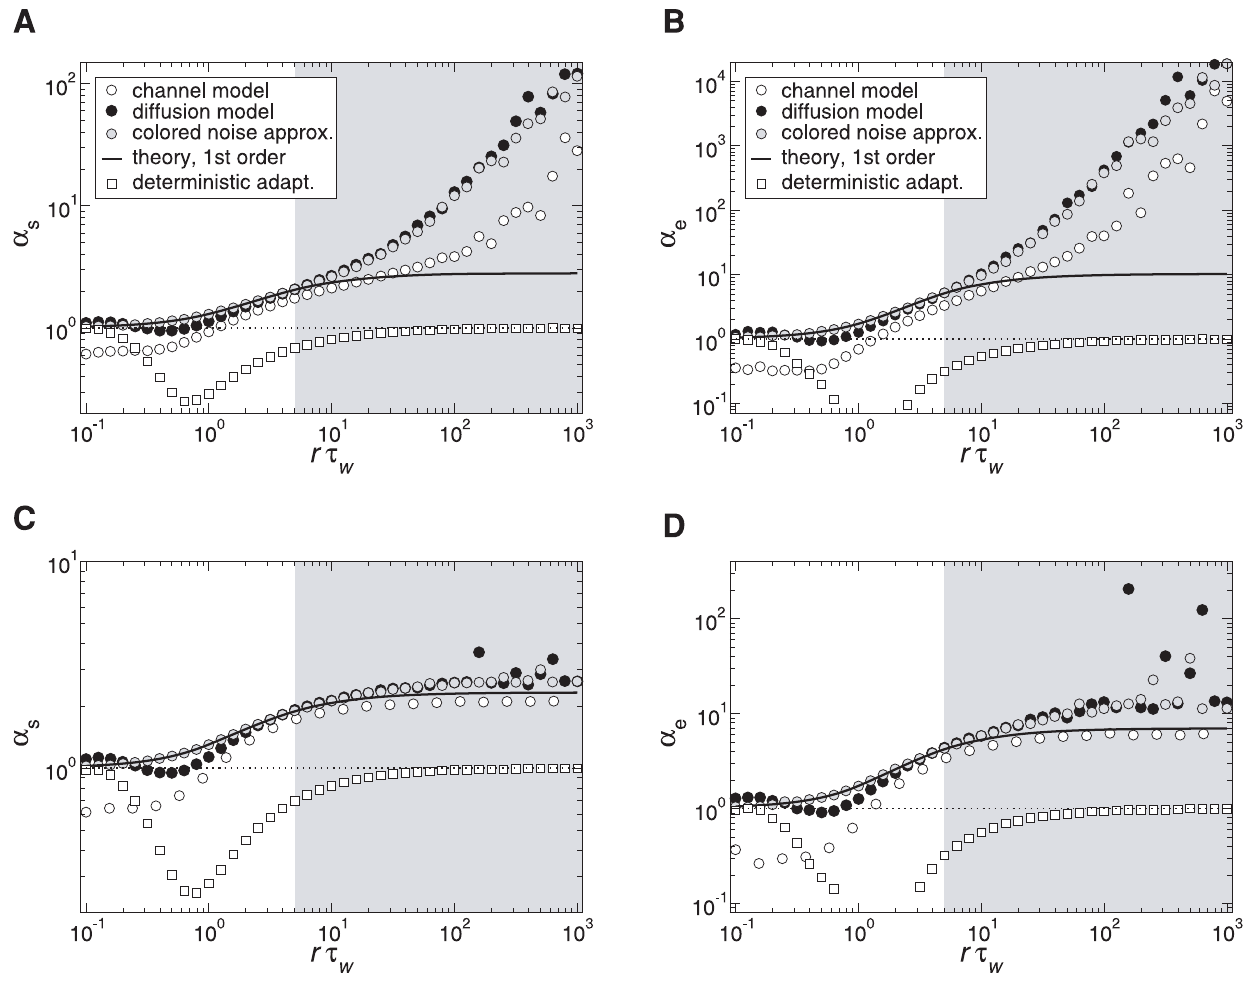
Figure 7. Shape parameters of the ISIH as a function of the time scale separation. A Rescaled skewness a s and B rescaled kurtosis a e for N a ~ 200 channels (corresponding ~ 0 : 1 ) for stochastic adaptation (circles) and D ~ 0 : 001 V 2 (113) and (114) is displayed by the solid line, the line a s = e ~ 1 is indicated by a dotted line. C and D corresponding plots for N a ~ 500 channels (corresponding to ~ 0 : 04 ) and D ~ 0 : 004 V 2